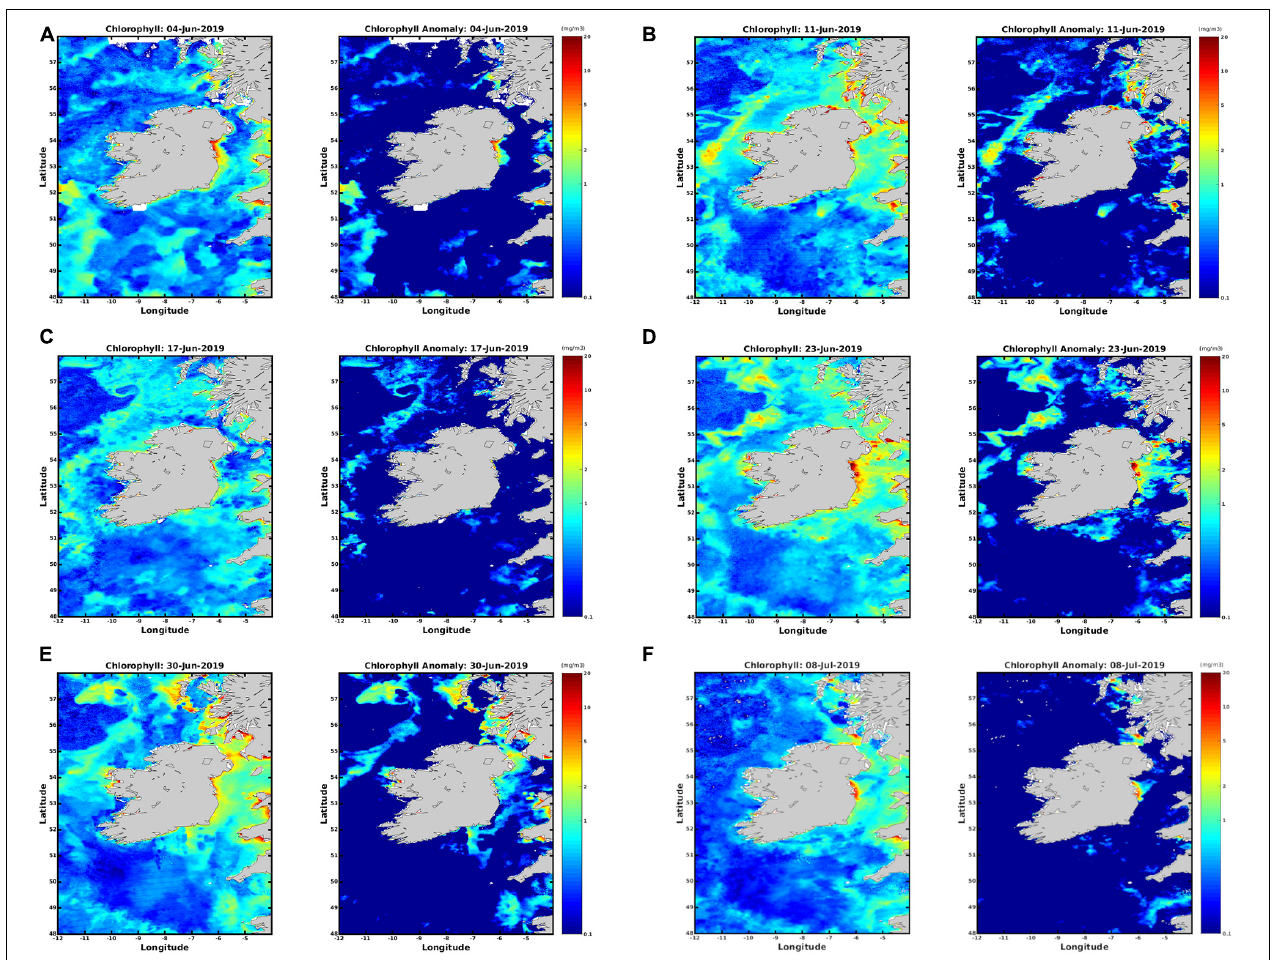
FIGURE 3 | OC5 IFREMER Level 4 Chlorophyll a data from the HAB bulletin weeks 24–28 (A–F) 4th June 2019 to 8th July